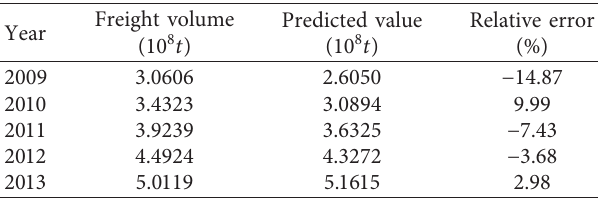
Table 2: Xi’an’s predicted freight volume from 2009 to 2013 based on the Gray GM (1, 1) model.